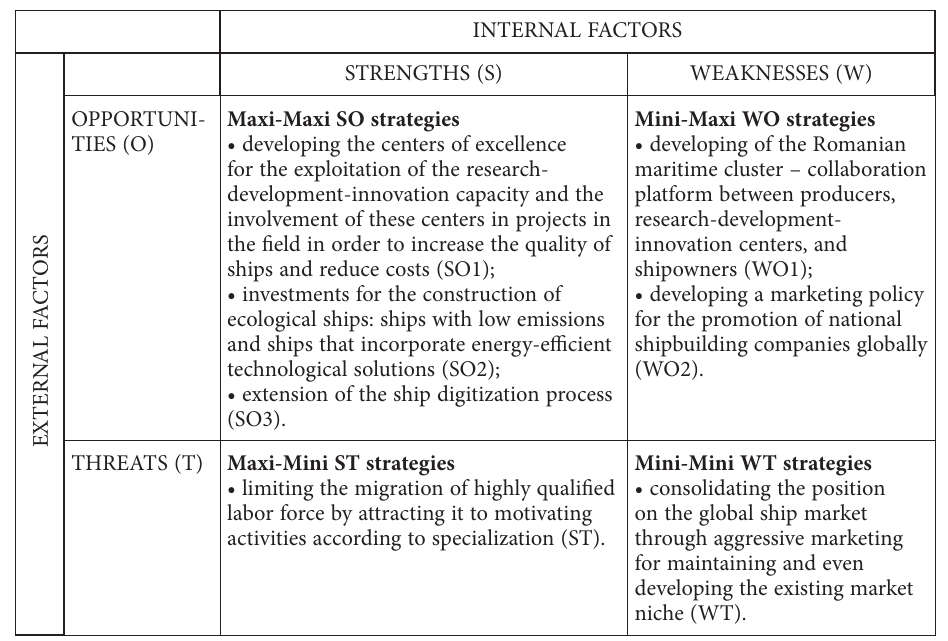
Table 2. TOWS matrix